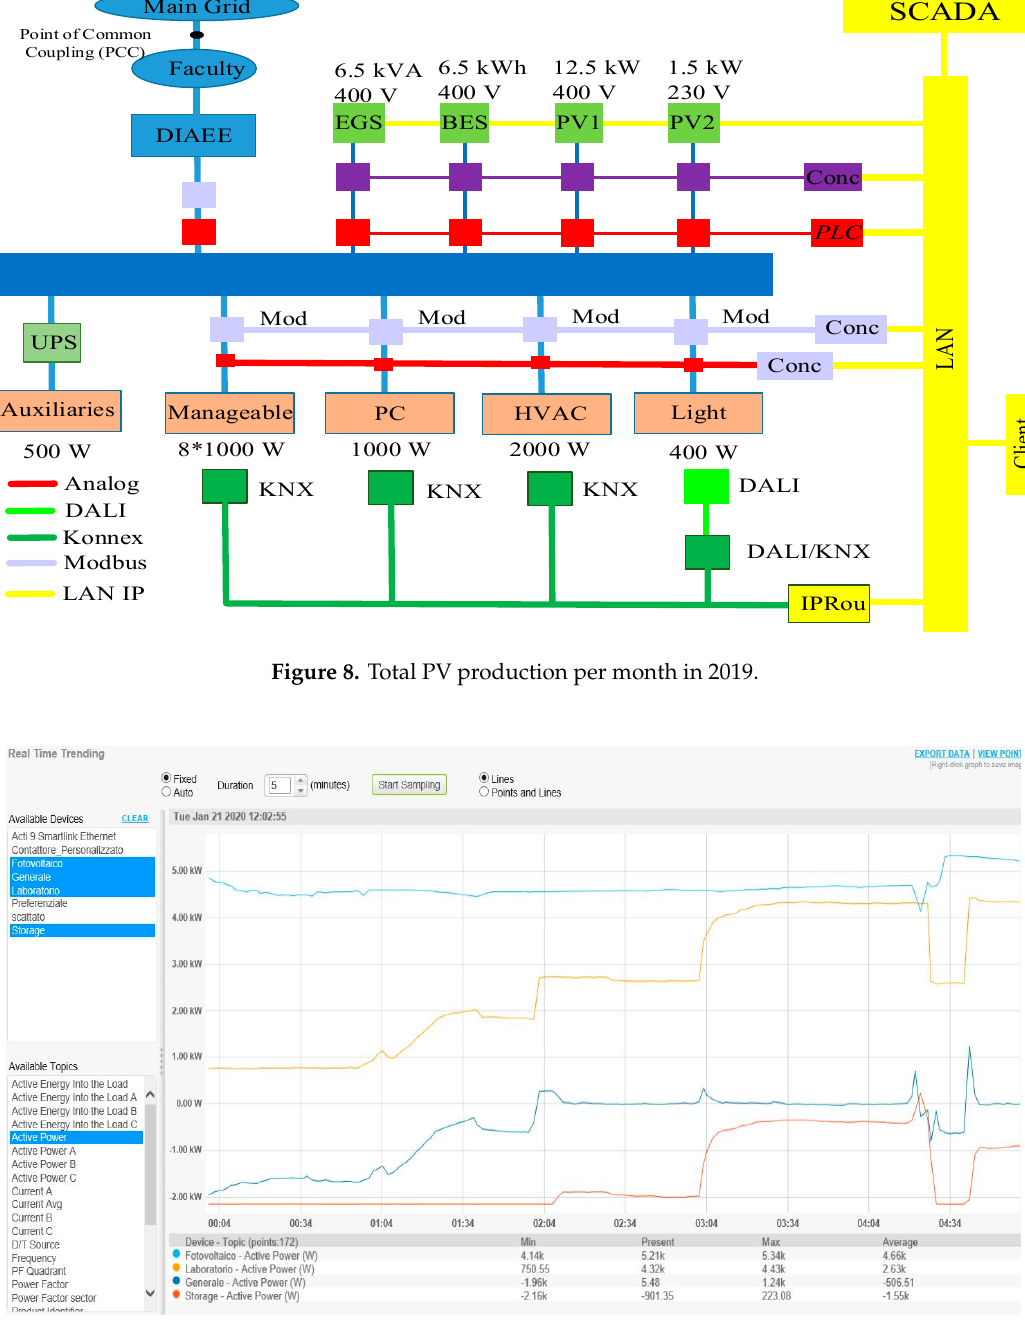
Figure 9. Real-time energy management in LAMBDA MG.